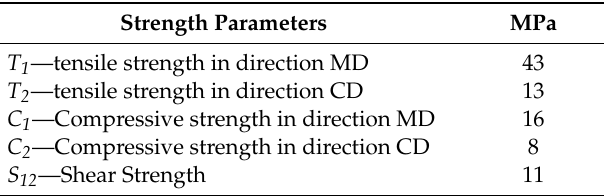
Table 3. Strength parameters of paper.